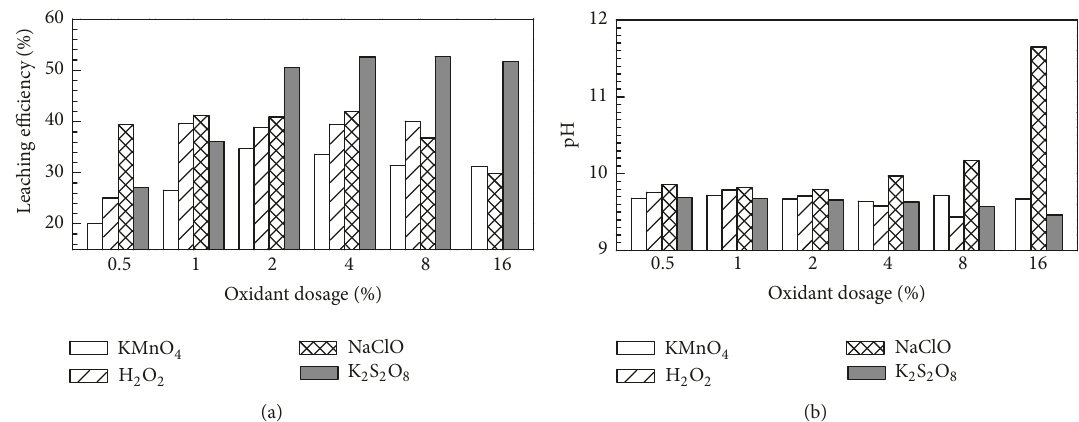
Figure 4: The effect of the oxidant on the uranium leaching efficiency and the ultimate pH.